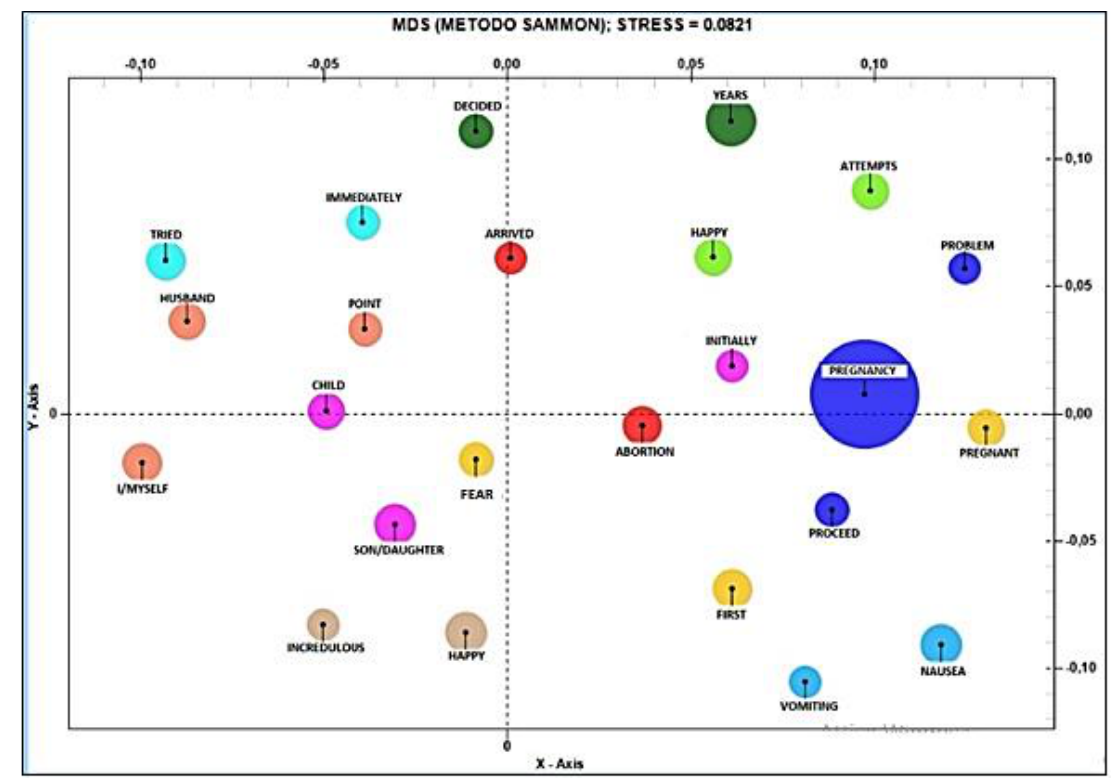
Figure 2. Co-word Analysis referring to the positive/negative positioning of the topic “perception pregnancy”.